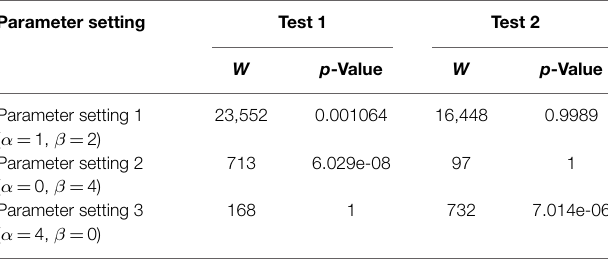
TABLE 1 | Results of Wilcoxon signed rank tests for the SD of angles of the easy and hard instances for the three parameter settings